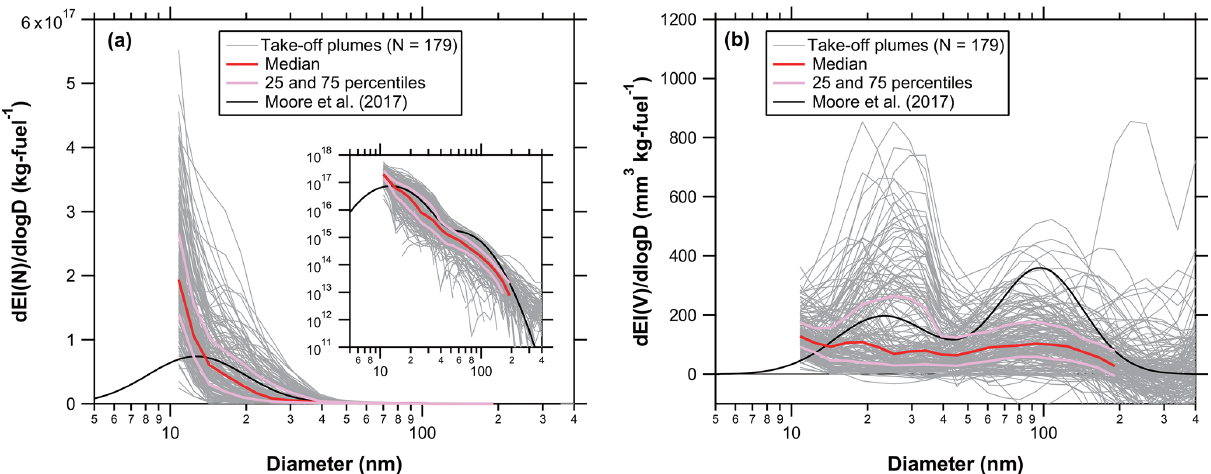
Figure 8. Size distributions of (a) number and (b) volume EIs derived from the EEPS data for the take-off plumes. The penetration efficiencies of particles through the sampling tubes (Fig. S1) are incorporated in these estimates. The shaded lines represent all data for the take-off plumes. The red and two pink lines indicate the median, 25th, and 75th percentiles, respectively. The black line represents the average size distributions from Moore et al. (2017a). A log-log plot of the same data is inserted in (a) for better visualization of the smaller